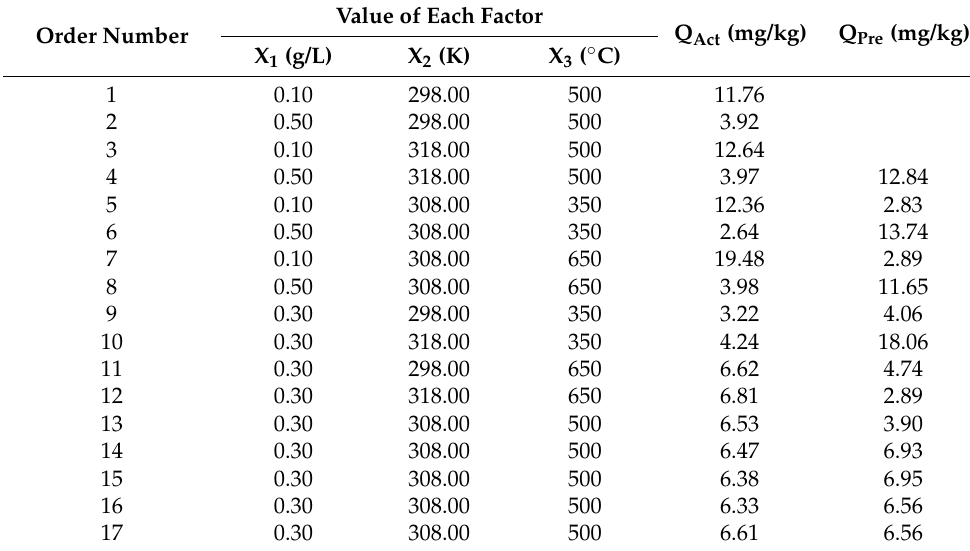
Table 5. Experimental design and analysis results (taking the preparation of biological carbon by 500 degrees of GBB as an